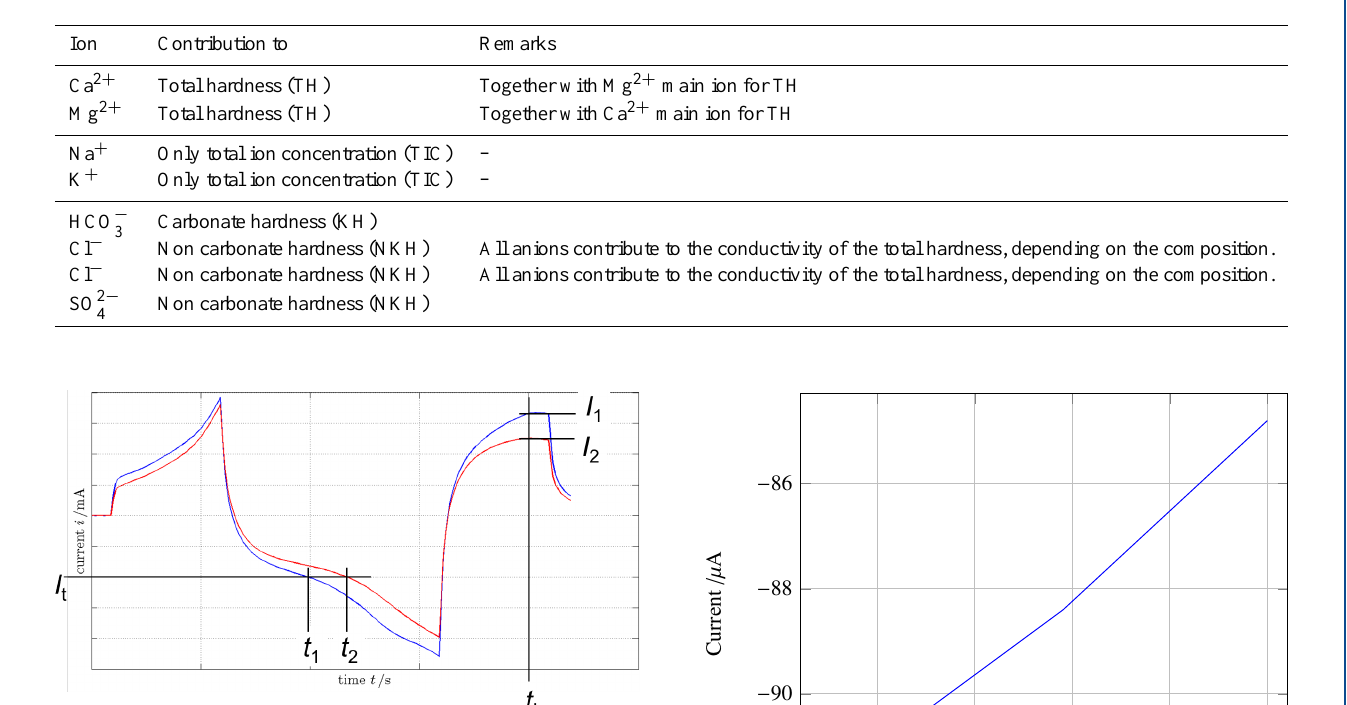
Figure 6. Impedance spectra of water samples with the same total hardness and di ff erent carbonate hardness. Figure 7. Two typical cyclic voltammetry measurements of di ff er- ent water samples.